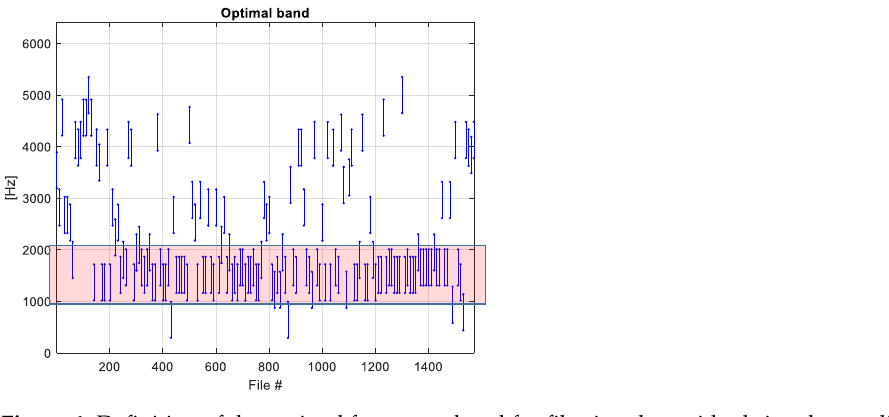
Figure 4. Definition of the optimal frequency band for filtering the residual signal according to the SES index—left TB.